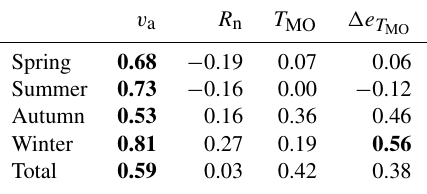
Table 3. Correlation coefficients for latent heat flux (LE) with wind speed ( v a ), net radiation ( R n ), surface water temperature ( T MO ), and vapour pressure deficit calculated with surface water temperature ( (cid:49)e MO ). Correlation coefficients over 0.5 are bold. Data are shown for the meteorological seasons 2014–2015 and the entire data set.